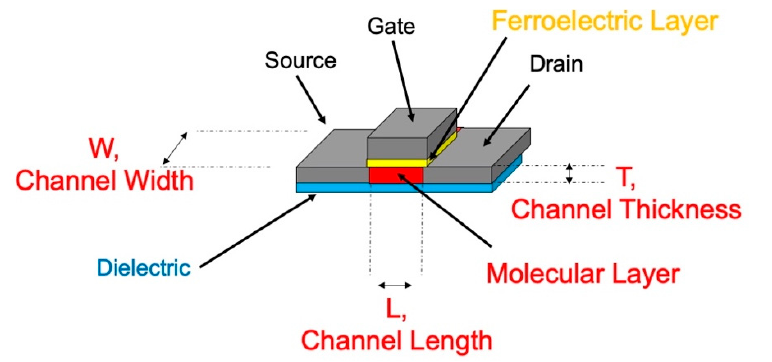
Figure 8. A schematic of the critical dimensions of nonvolatile molecular transistor devices fabricated from spin crossover complexes. The ferroelectric layer would typically be a molecular ferroelectric that also serves as one of the gate dielectric layers, and in practice, such a device would be both top and bottom gated, so as to provide uniform electric field across the ferroelectric, so in turn, there is uniform ferroelectric polarization in the ferroelectric dielectric layer.